Question: How would you classify this visualization?
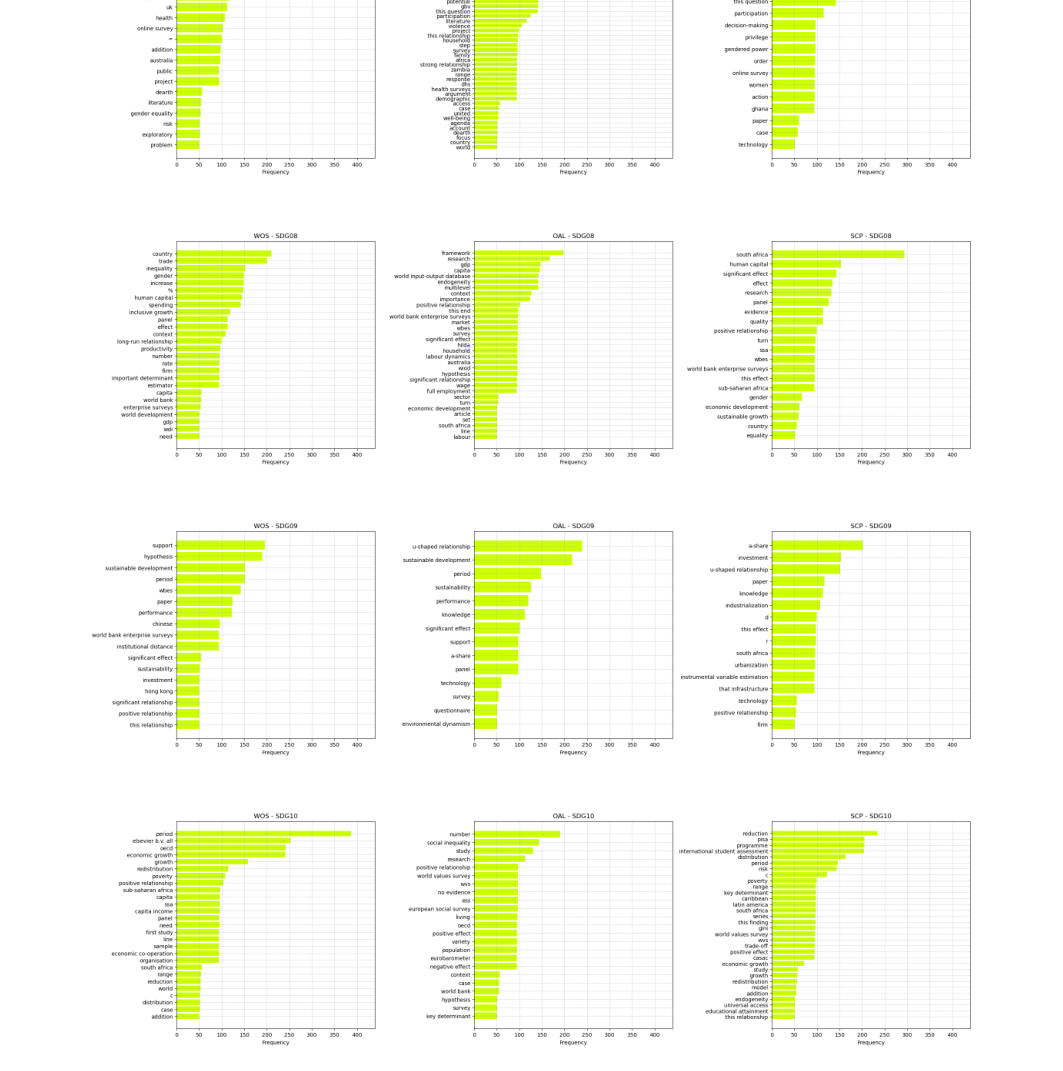
Answer: bar